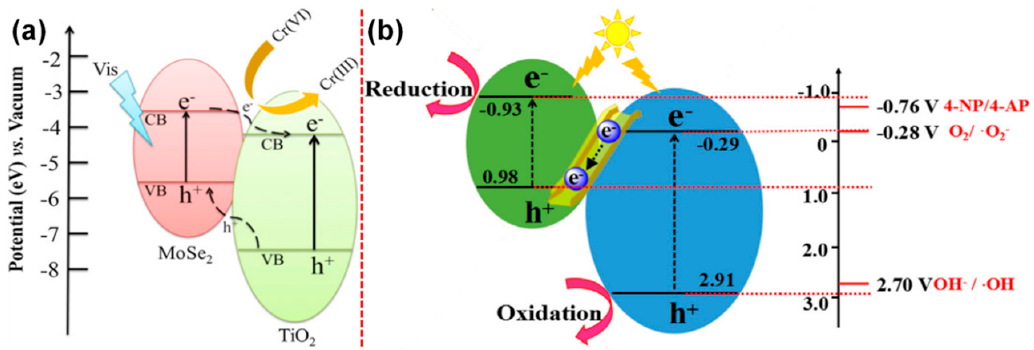
Figure 16. Charge transfer mechanism in MoSe 2 / TiO 2 ( a ) heterojunction and ( b ) Z-scheme (reproduced with permission from refs.